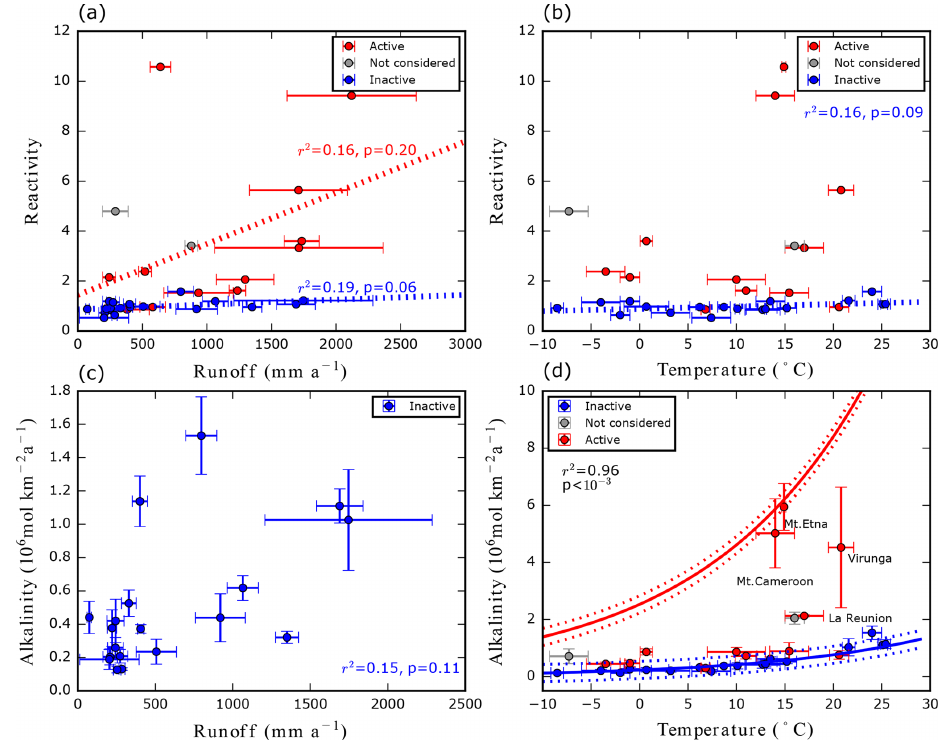
Figure 2. Panel (a) shows the runoff–reactivity relationship of all studied volcanic fields. The blue regression line (IVFs) suggests almost no correlation of reactivity with runoff; also, for the AVFs, no significant correlation is identified ( r 2 = 0 . 16, p = 0 . 20). (b) Reactivity vs. temperature suggests no bias of reactivity due to a temperature effect for AVFs, as reactivity is based on a temperature normalized parameterization. For the IVFs ( r 2 = 0 . 16, p = 0 . 09), no bias with temperature can be identified due to the good correlation of alkalinity fluxes with land surface temperature (blue line). (c) Runoff vs. alkalinity flux rates for inactive volcanic fields shows no significant correlation ( r 2 = 0 . 15, p = 0 . 11). (d) Temperature vs. alkalinity flux rates for all volcanic fields of the study. The blue line represents the new scaling law for IVFs and the red line the new scaling law for AVFs with 100% Holocene area coverage (calculated deviation is represented by dashed lines). r 2 and the p value are derived by a linear regression of calculated alkalinity flux rates vs. observed alkalinity flux rates for all volcanic